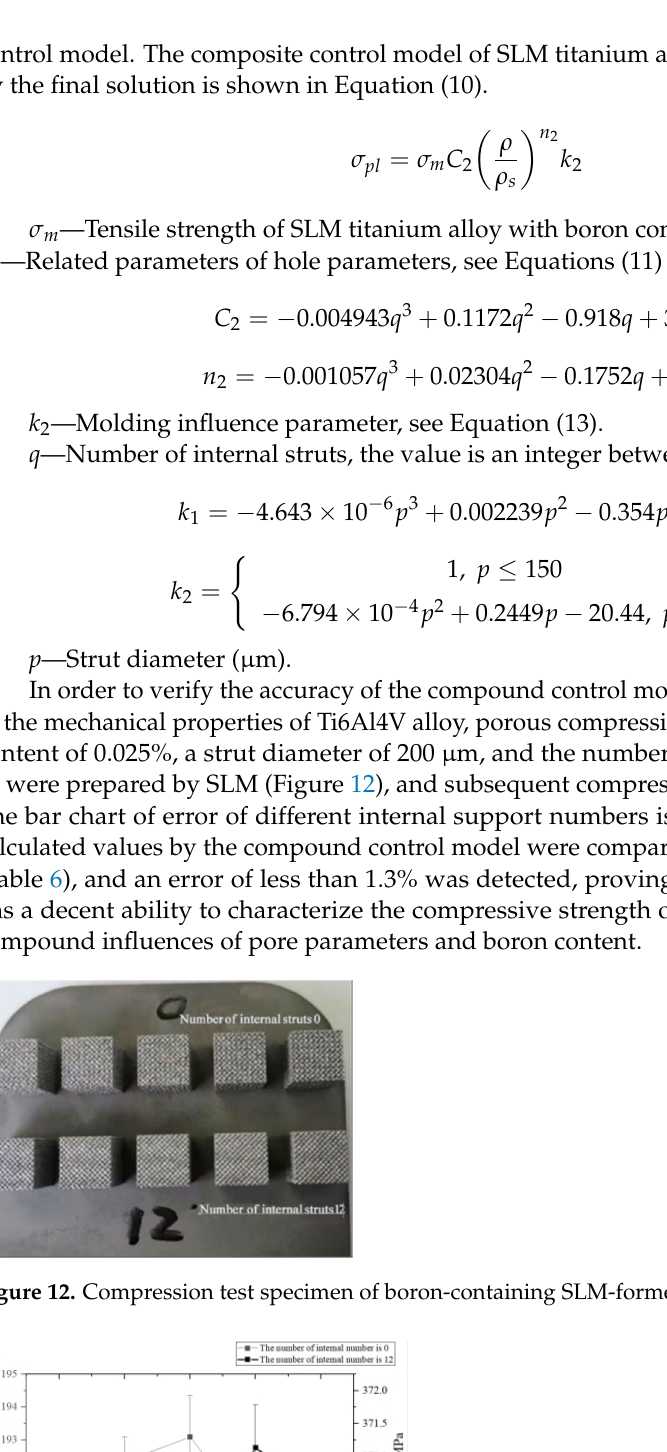
Figure 12. Compression test specimen of boron-containing SLM-formed porous Ti6Al4V alloy. Table 6. Comparison of calculated and experimental values.